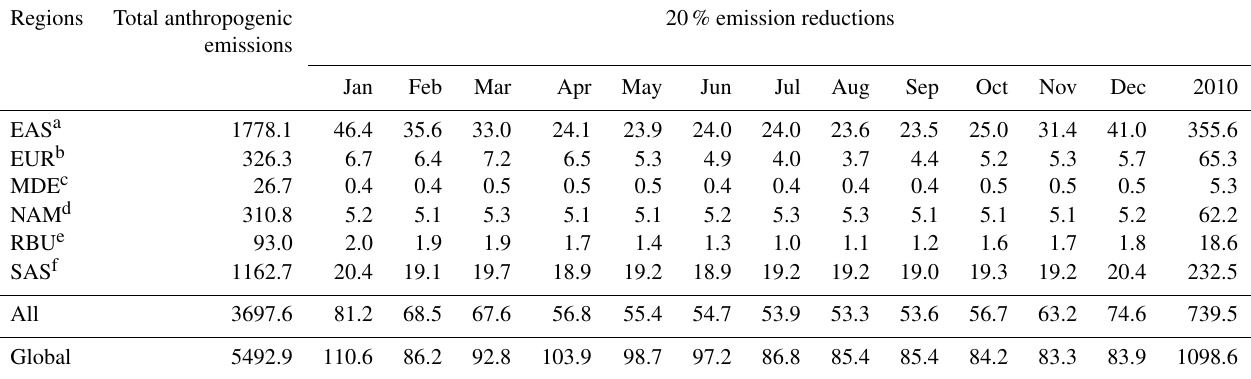
All 3697.6 81.2 68.5 739.5 Global 5492.9 110.6 86.2 92.8 103.9 98.7